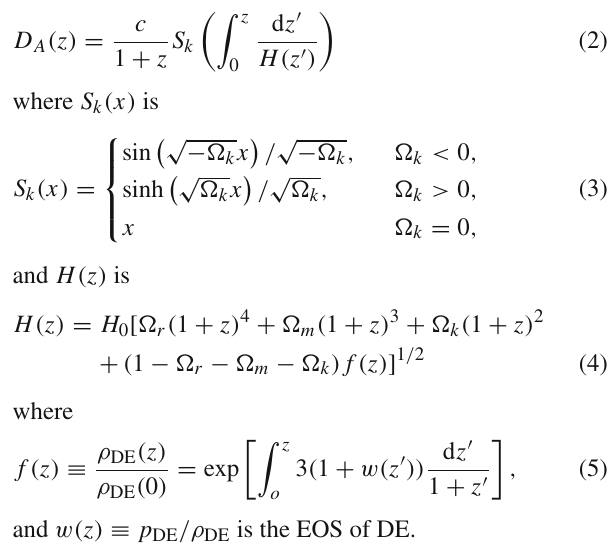
Table 1. We run CosmoMC [18] in the (cid:2) CDM model as the basic model, where there are six free cosmological param- is the density of the baryonic matter today, (cid:3) c h 2 is the cold dark matter density today, 100 θ MC is 100 times the ratio of the angular diameter distance to the large scale structure sound horizon, τ is the optical depth, n s is the scalar spec- trum index, and A s is the amplitude of the power spectrum of primordial curvature perturbations. The EOS of DE is w = − 1 . 036 ± 0 . 056 in the w CDM model at 68% confidence level (C.L.). The triangular plot of it indicates that the prediction of (cid:2) CDM is within the 68% confidence region in this figure, which seems to be in conflict with the w 0 , w a values in Table 1. Actually, the probabilities are the integrated probabilities, which means the values in Table 1 have been marginalized over all the other parameters except the aimed parameter. Due to the strong correlation